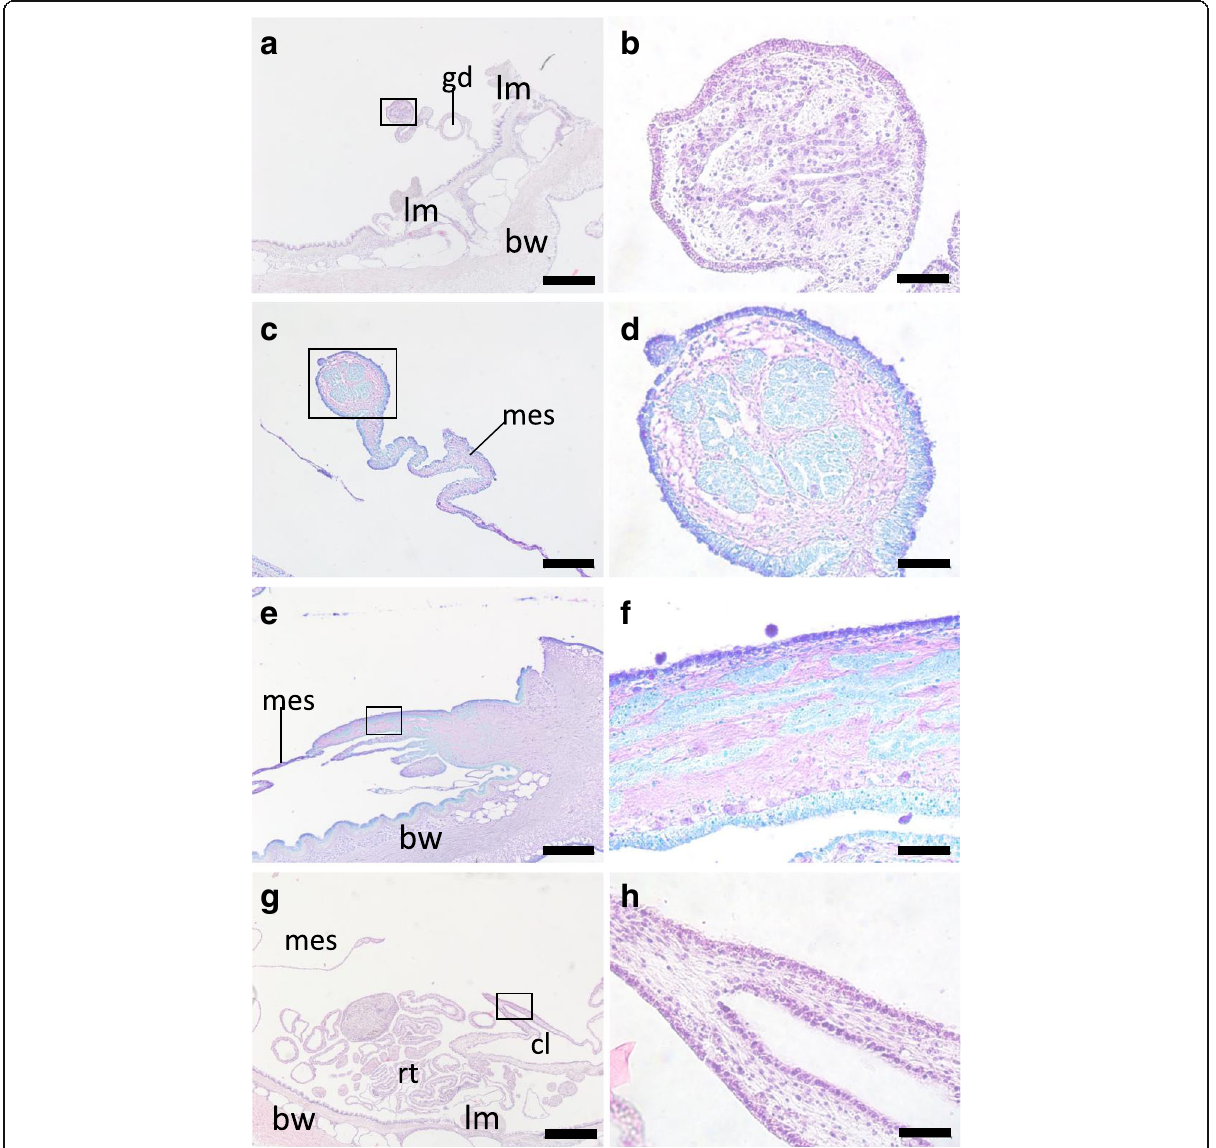
Fig. 7 Histology of the tissues at stage III. Histological sections of the anterior ( a - f , i ) and posterior ( g , h ) regions of the body at stage III. b , d , f , h are high-magnification views of the boxed areas in a , c , e , g , respectively. a , b Cross section, 6 dpe, stained with HE. c , d Cross section, 7 dpe, stained with TB. e , f Longitudinal section of the oral region, 7 dpe, stained with TB. The right side of this figure is anterior. g , h Posterior region, 6 dpe, stained with HE. The animal was sliced perpendicular to the oral-aboral axis but a longitudinal section of the regenerating tube was made. In the lumen, a mass of obscure material is observed (arrowhead). bw, body wall; cl, cloaca; gd, gonadal duct; mes, mesentery; rt., respiratory trees. Scale bar 500 μ m in a , e , g ; 200 μ m in c ; 50 μ m in b , d , h ,